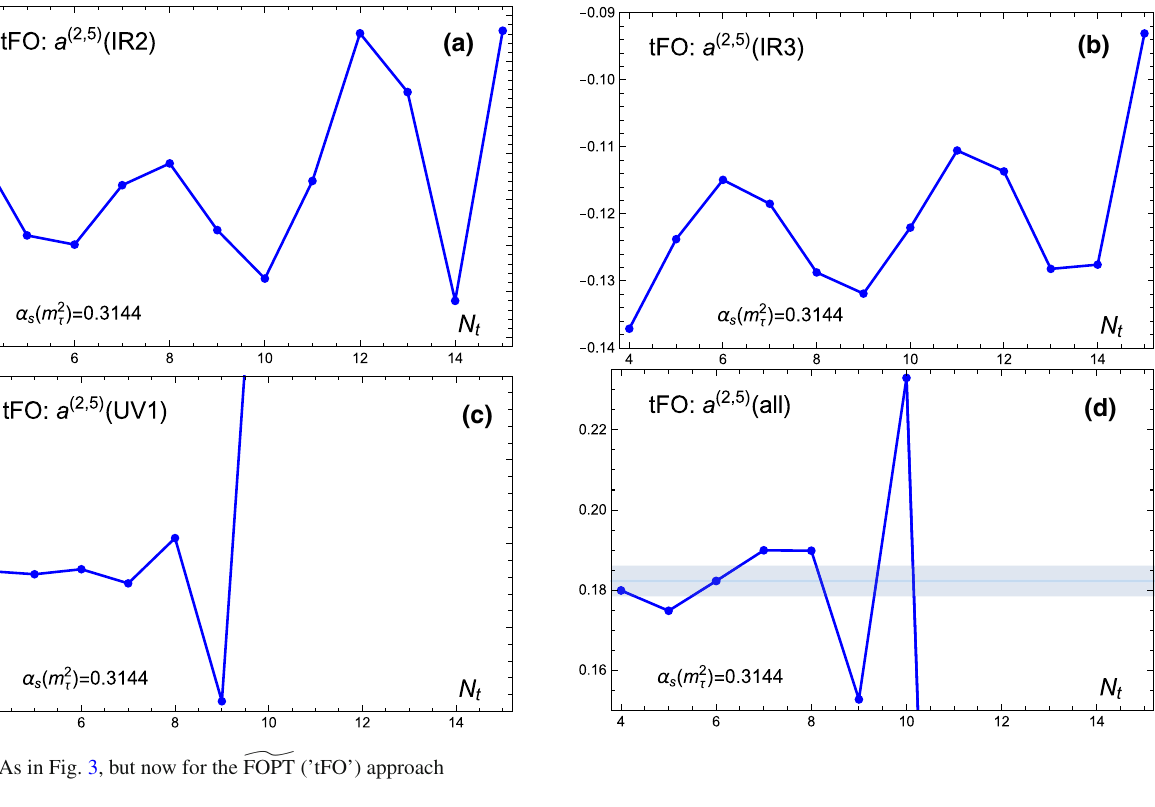
Table 3 The extracted values of α s ( m 2 τ ) from FESR moments a ( m , n ) (σ m ) under the assumption of zero condensate contributions, in the FOPT (FO), CIPT (CI) and PV approach, with the corresponding truncation indices N t = 9 , 10 , 10. Only the experimental uncertainties